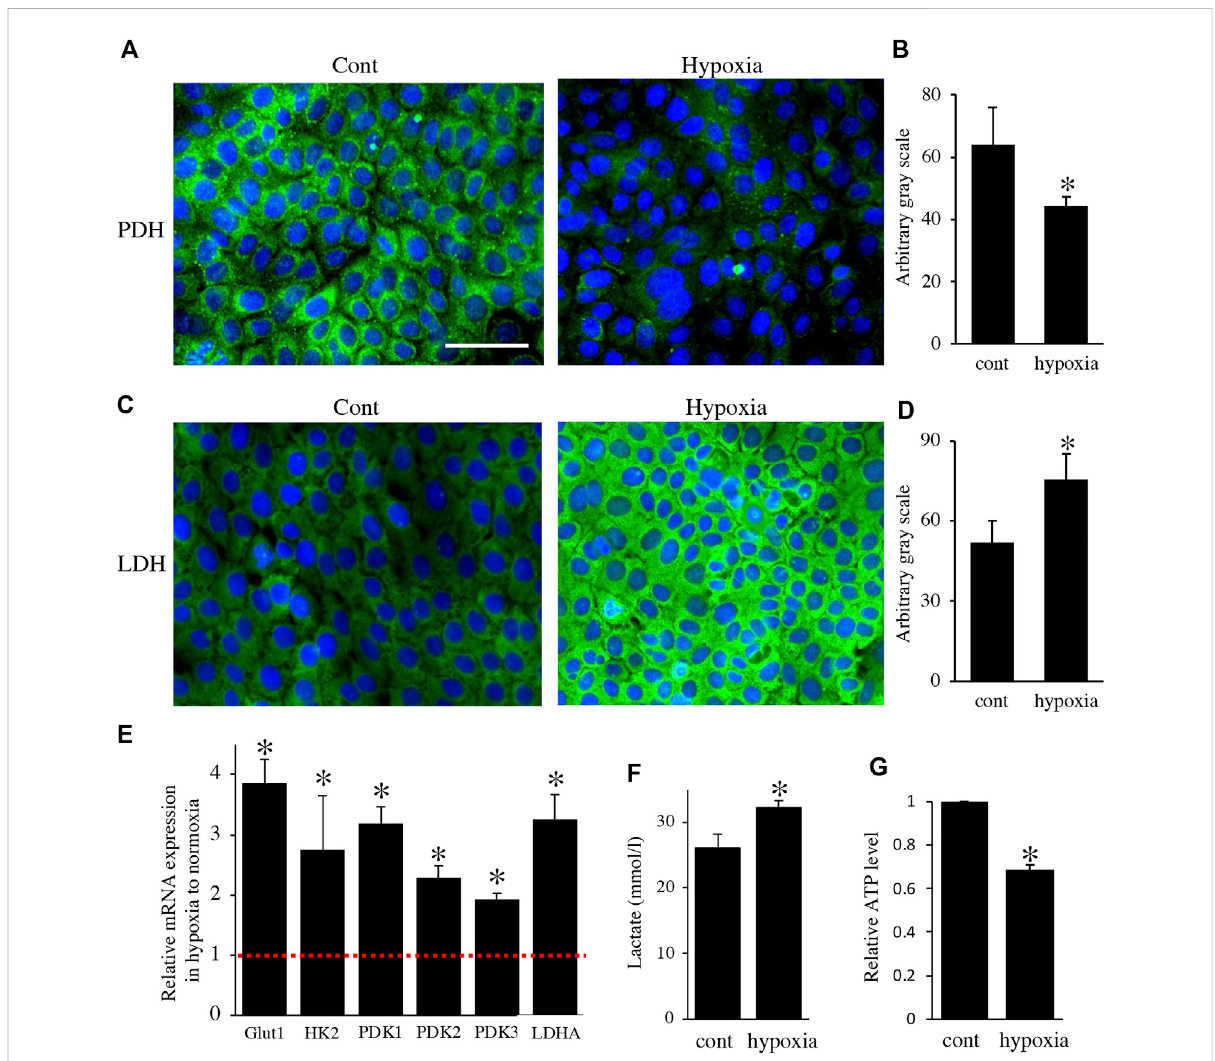
FIGURE 4 Environmental hypoxia induced energy metabolic shift to glycolysis in HAT7 cells. Immunostaining for PDH (A) and LDH (C) in HAT7 cells culturedundernormoxia(left)andhypoxia(right)for48 h.NucleiwerestainedwithDAPI(blue).Quanti fi cationofPDH (B) andLDH (D) fl uorescence; n = 3 each. (E) Relative expression of the target genes in HAT7 cells under hypoxia for 48 h under normoxia; n = 3. (F) Lactate secretion into the culturemedium ofHAT7cells incubated for48 hundernormoxiaorhypoxia; n =3. (G) IntracellularATPproduction inHAT7cellsincubatedfor 48 h under normoxia or hypoxia ( n = 3). Data are presented as the mean ± SD. * p < 0.05 (unpaired two-tailed Student ’ s t